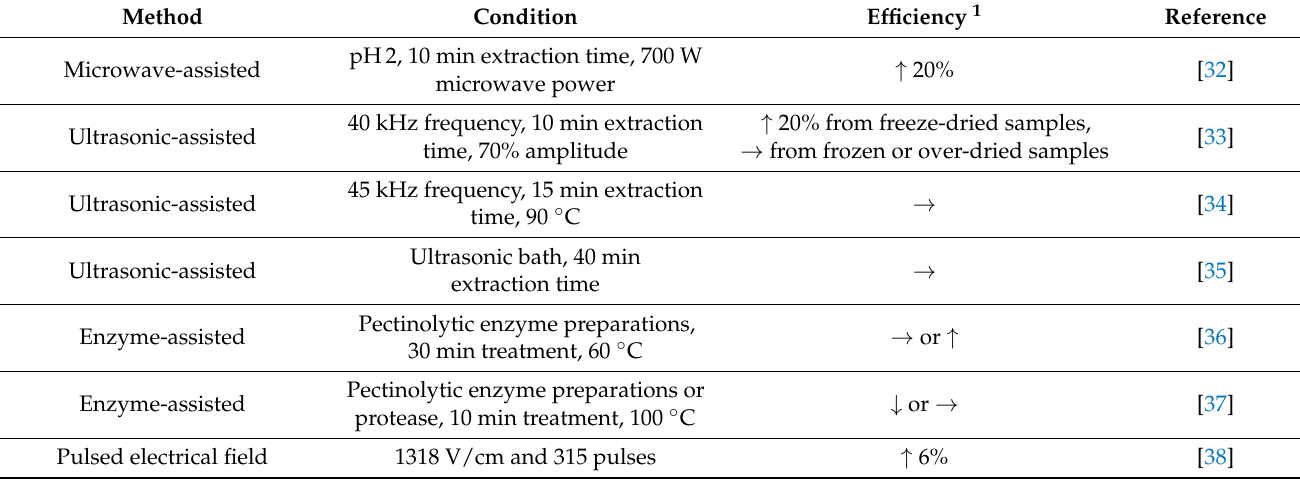
Table 1. Non-conventional extraction methods of blackcurrant